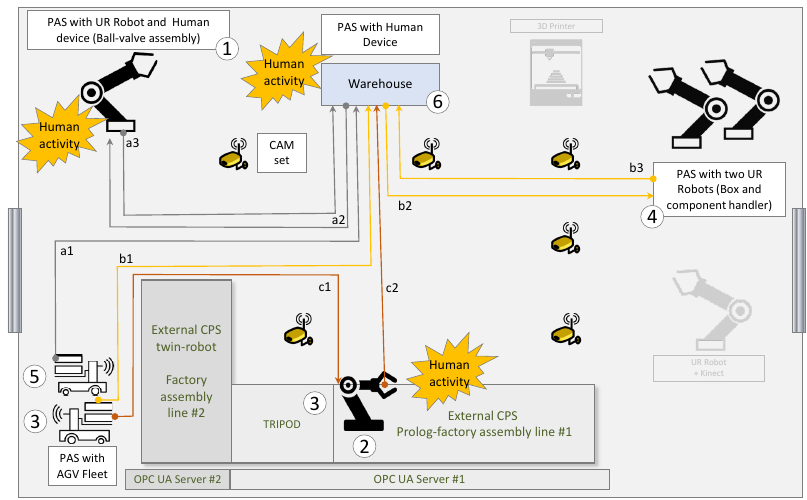
Figure 9. Realized MESS layout: involved CPSs, human activity, and implemented